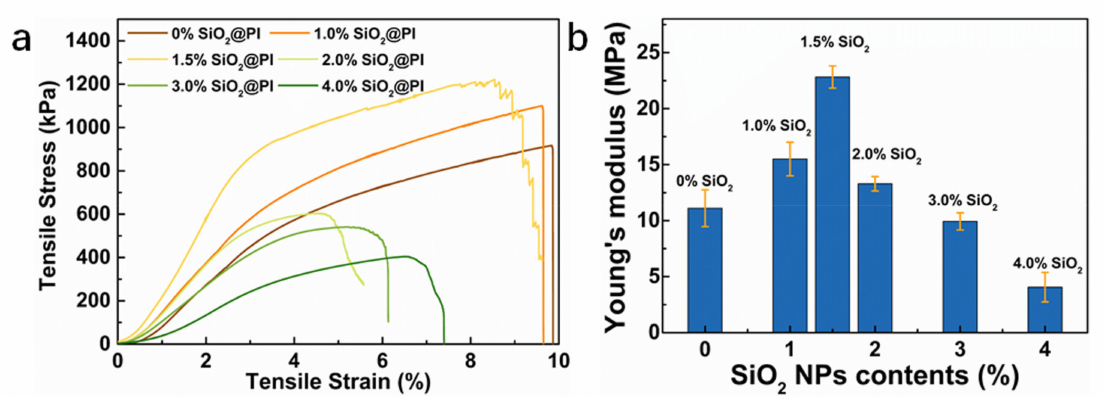
Figure 6. Mechanical characterization of SiO 2 @PI hybrid membranes: ( a ) tensile stress–strain curves; ( b ) Young’s